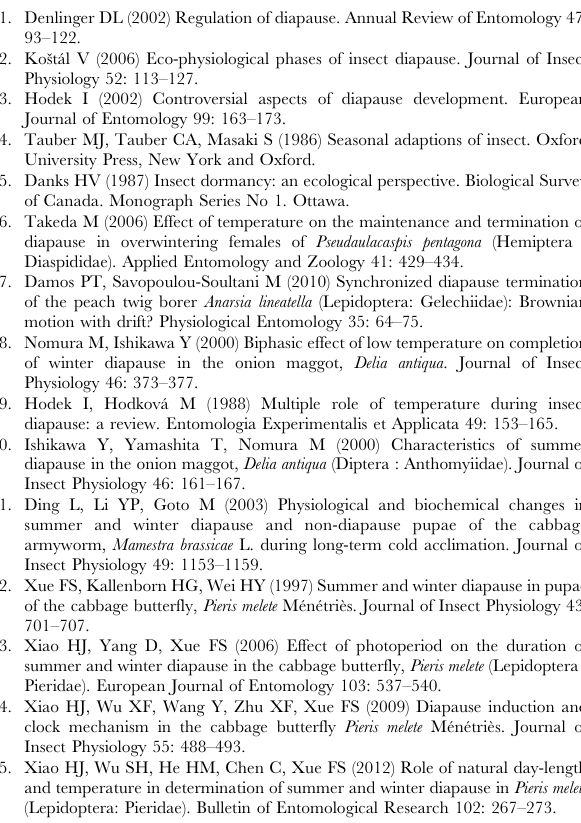
days. The hatched bar indicates the period of cold exposure. Values followed by different letters are significantly different by Bonferroni test (P , 0.05). (TIF) Figure S2 Cumulative eclosion in summer diapausing pupae of P. melete. The diapausing pupae were transferred to LD12.5:11.5 at 20 u C after exposure to 10 u C and DD for different days. The hatched bar indicates the period of cold exposure. Values followed by different letters are significantly different by Bonferroni test (P , 0.05). (TIF) Figure S3 Cumulative eclosion in summer diapausing pupae of P. melete . The diapausing pupae were transferred to LD12.5:11.5 at 20 u C after exposure to 15 u C and DD for different days. The hatched bar indicates the period of cold exposure. Values followed by different letters are significantly different by Bonferroni test (P , 0.05). (TIF) Figure S4 Cumulative eclosion in winter diapausing pupae of P. melete . The diapausing pupae were transferred to LD12.5:11.5 at 20 u C after exposure to 1 u C and DD for different days. The hatched bar indicates the period of cold exposure. Values followed by different letters are significantly different by Bonferroni test (P , 0.05). (TIF) Figure S5 Cumulative eclosion in winter diapausing pupae of P. melete . The diapausing pupae were transferred to LD12.5:11.5 at 20 u C after exposure to 5 u C and DD for different days. The hatched bar indicates the period of cold exposure.